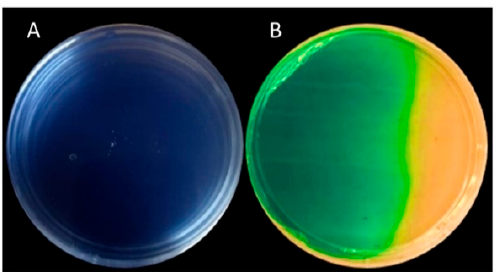
Figure 3. Petri plate with sterile distilled water as a control ( A ) and cell-free extracts of P. fluorescens ( B ). The scale of color is as follows for siderophore production: blue = none, green (blue + pale yellow) = limited, yellow = very strong.